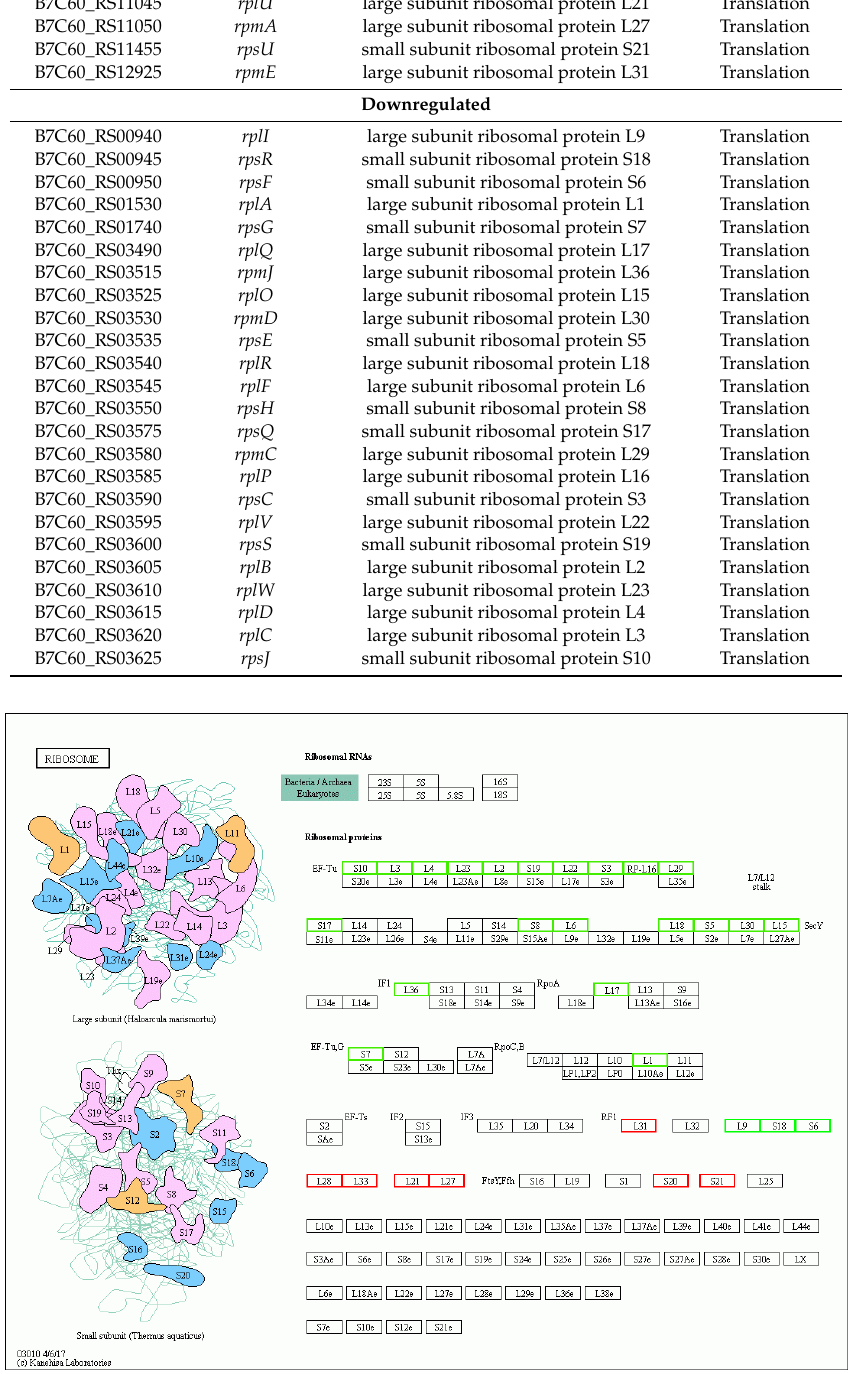
Figure 7. Candidate unigenes related to salt tolerance. Red frames represent upregulated genes, while green frames represent downregulated genes.